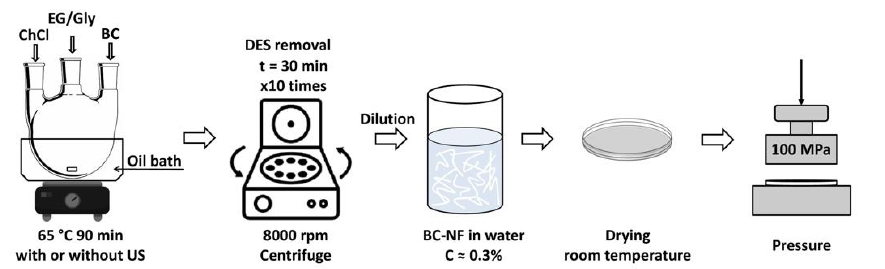
Figure 1. Sample preparation scheme of cellulose films processed in the ChCl/EG and ChCl/Gly mixtures.